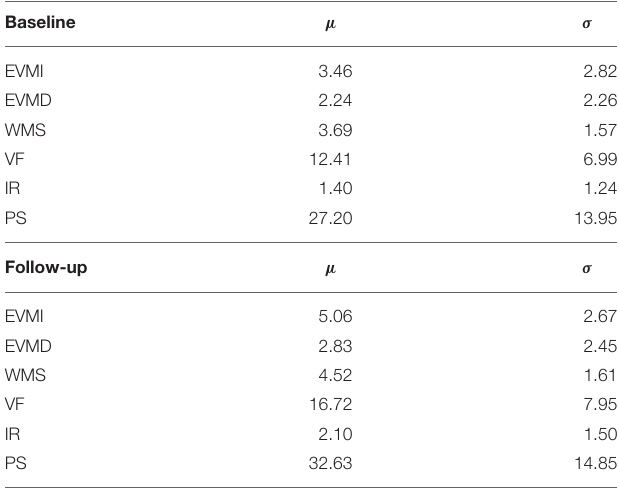
TABLE 2 | Cognitive scores for traumatic brain injury subjects, at ∼ 2 weeks and 6 months post injury (baseline and follow-up,